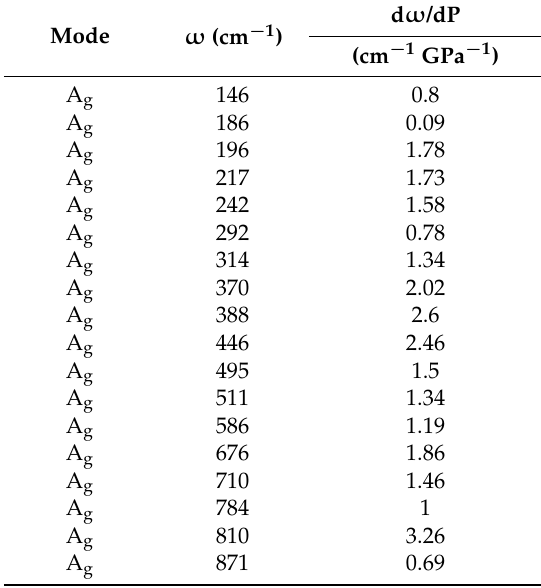
Table 3. The Raman active modes of the HP phase of MnWO 4 at 34 GPa with their pressure